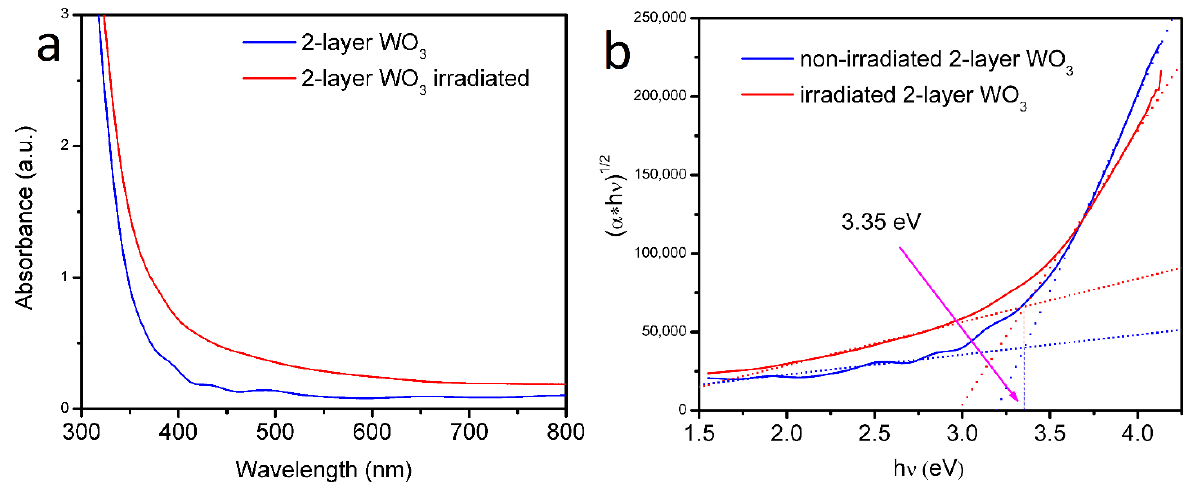
Figure 4. ( a ) absorption spectra and ( b ) Tauc plot of double-layer irradiated and non-irradiated WO 3 thin films. Band gap values are indicated.